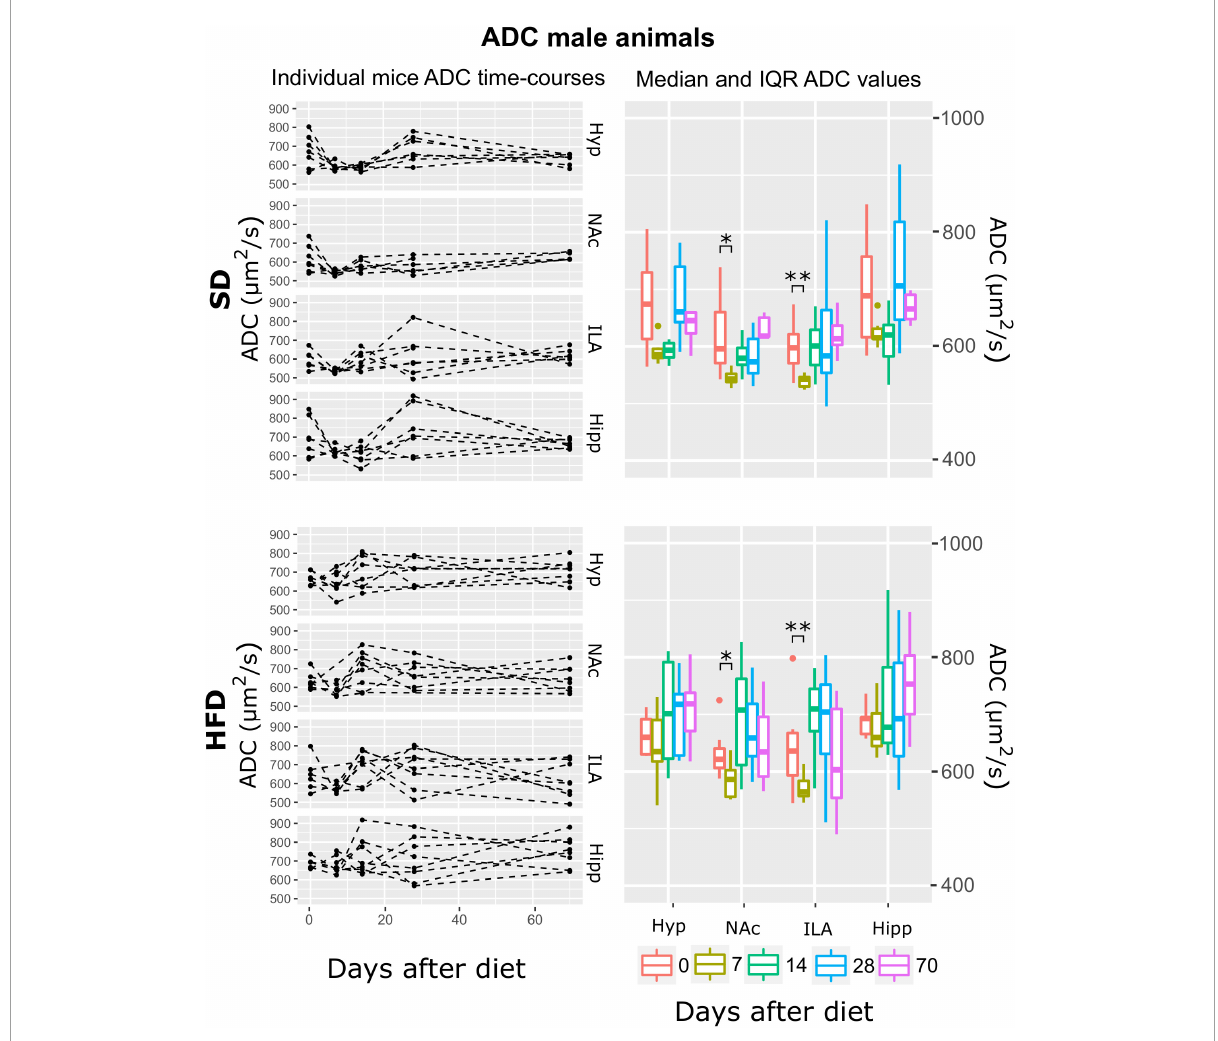
FIGURE4 ADC changes on male mice during HFD or SD consumption. ADC evolution on SD-fed (top panels) or HFD (bottom panels) male mice in the four brain areas assessed: hypothalamus (Hyp), nucleus accumbens (NAc), ipsilateral area (ILA) and hippocampus (Hipp) at all time points measured. Left panels depict the individual regional values at each time point, with dashed lines connecting the neighboring points. Right boards illustrate box plots of ADC vs. time-point for the 4 regions assessed, with each color representing the specific time-point evaluated, as days after diet diversification (* p < 0.05, ** p <